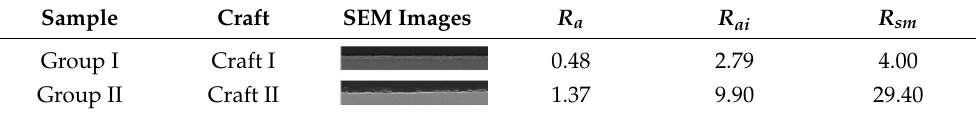
Figure 7. Fabrication processes for obtaining strain gauges and the resulting sidewall quantity. ( a ) Two fabrication processes. The SEM images of micro-morphology produced by ( b ) the Cr-mask and positive photoresist and ( c ) film mask and negative photoresist. Table 4. The sidewall surface in two groups of fabricated strain gauge